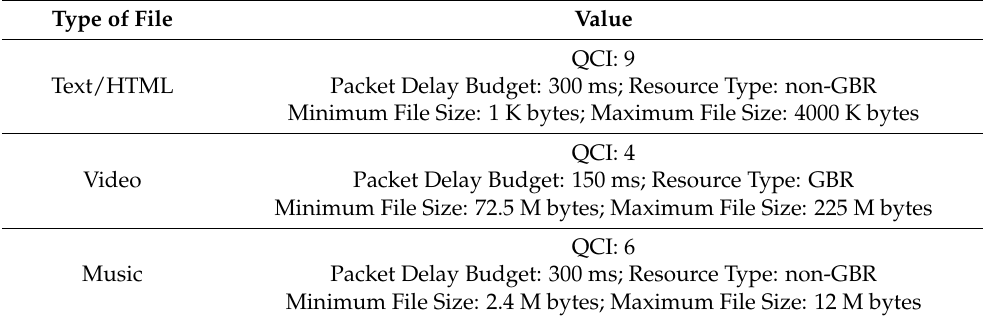
Table 2. Types and parameters of